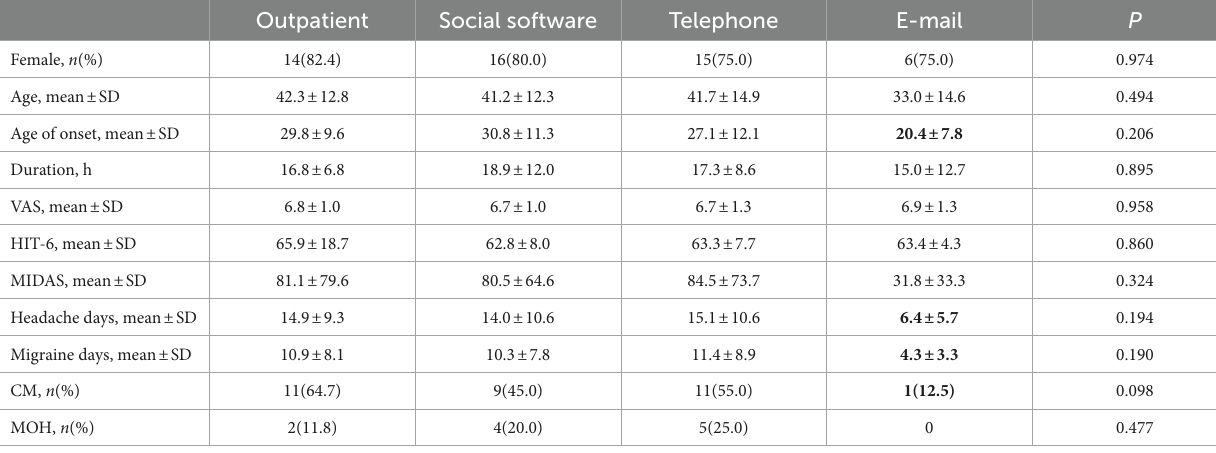
TABLE 1 Baseline demographics in each